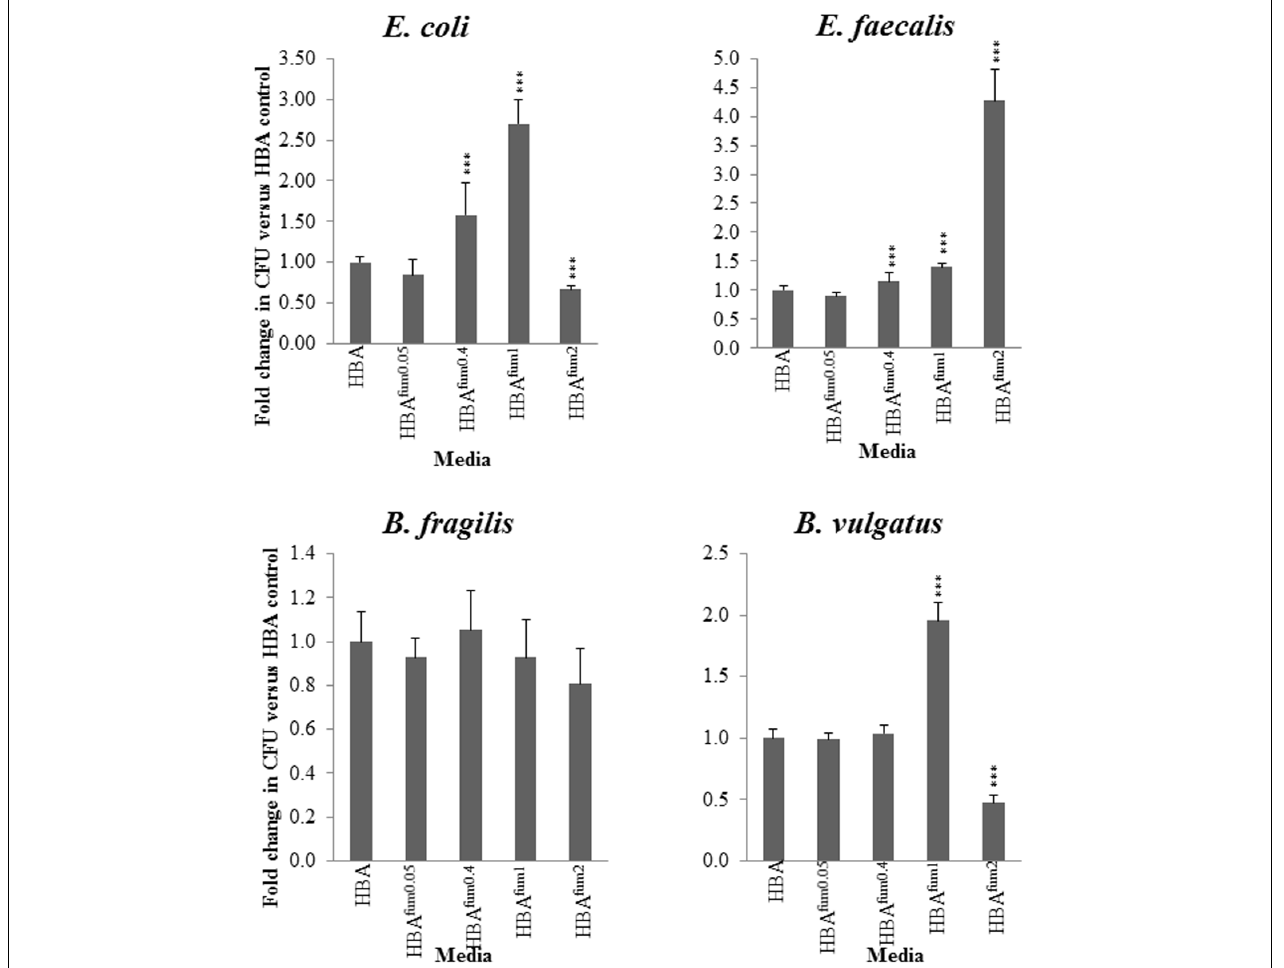
FIGURE 5 | Quantitative effects of varying concentrations of sodium fumarate on enteric bacterial species. B. fragilis , B. vulgatus , E. faecalis , and E. coli were chosen as representative bacteria of the enteric environment. Each species was cultured on HBA plates with varying concentrations of sodium fumarate; the number following Fum indicates the percentage of sodium fumarate in the HBA plate. Bacteria were then collected and the CFU were quantified. Fold changes were calculated relative to the CFU of the same species cultured on HBA from quadruplicate counts. ∗∗∗ indicates p < 0.001.